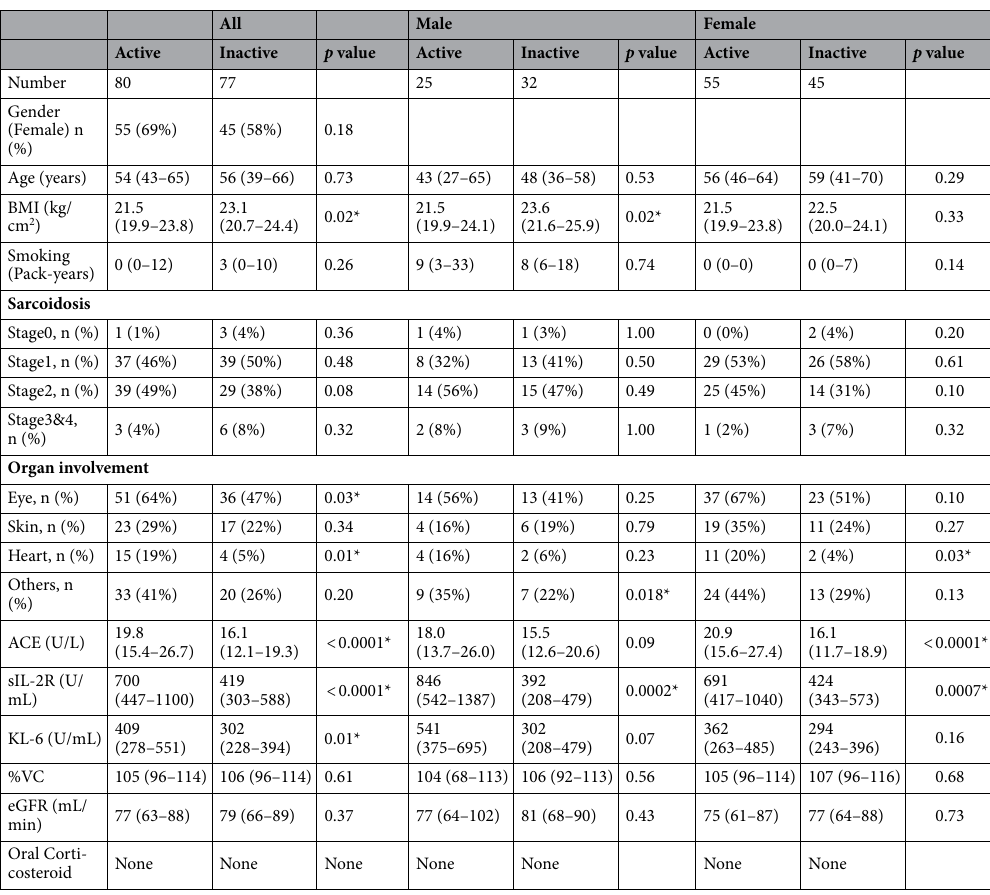
Table 2. Comparison of characteristics of the patients with sarcoidosis between active and inactive state. Data are expressed as median and interquartile range (IQR, Q1-Q3). The clinical characteristics were compared using Mann–Whitney U-test or Fisher’s exact test. Statistical significance was accepted as p < 0.05 and marked by an